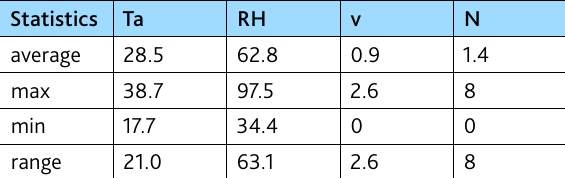
Table 3. Statistics on the weather conditions in Banja Luka (Bosnia and Herzegovina) during the measurement